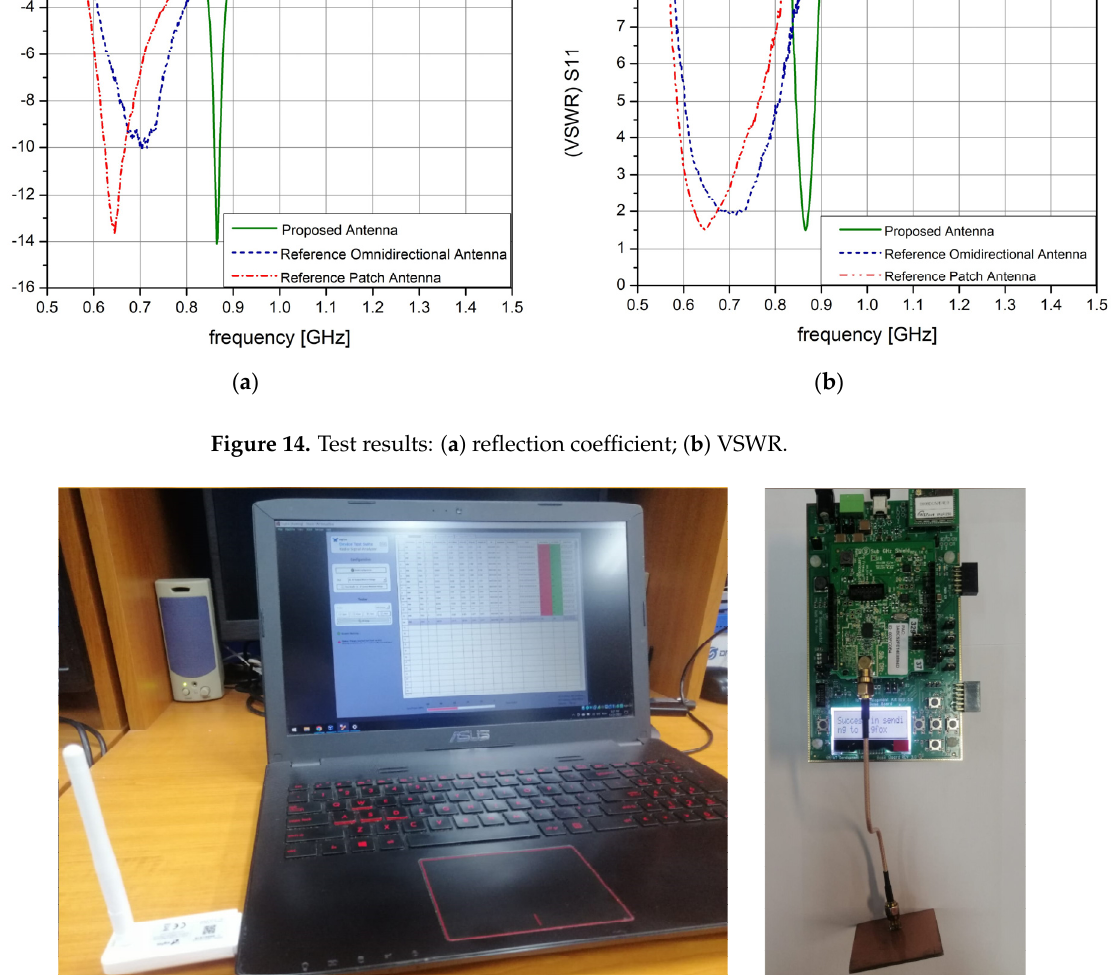
Figure 14. Test results: ( a ) reflection coefficient; ( b ) VSWR.